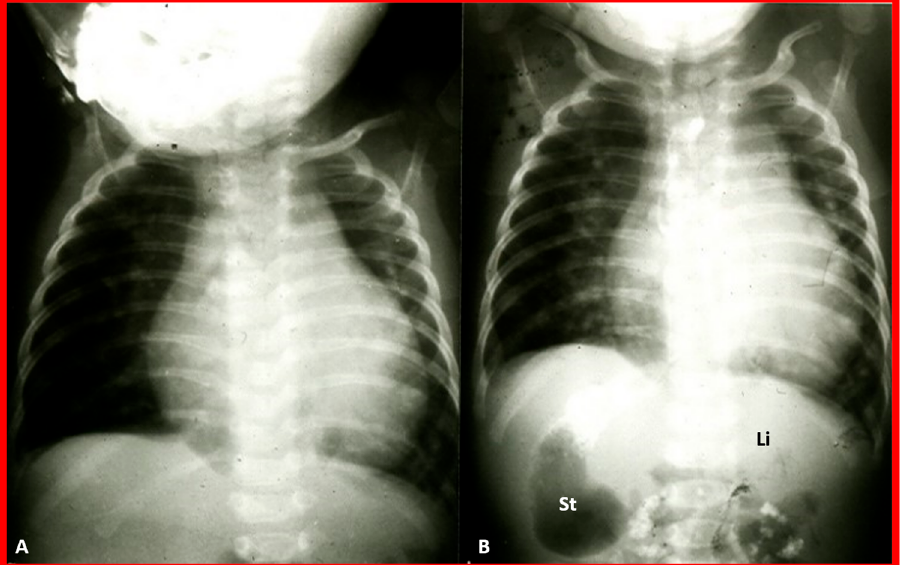
Figure 20. Value of stomach (St) gas shadow in determining situs localization is shown in this figure. In ( A ), the St gas bubble was not seen, and therefore, visceral situs could not be classified. In a subsequent chest X-ray ( B ), the St gas was seen, indicating situs inversus. This case exemplifies the requirement for seeing the St gaseous opacity on the chest X-ray. Li, liver. Modified from reference [3]. If the lobes of the liver are of equal size or if the liver is located in the midline (Figures 2A and 9), regardless of the location of the gaseous opacity of the stomach, situs ambiguous is likely, and the possibility of heterotaxy syndromes (asplenia/polysplenia) exists [2,3]. The rule of visceroatrial concordance appears to have a greater degree of dependability than the P wave axis in an ECG in accurately detecting the situs of the atria [3–5]. Although this well-established principle of visceroatrial concordance is fairly helpful, it has been found to be misleading in a few cases